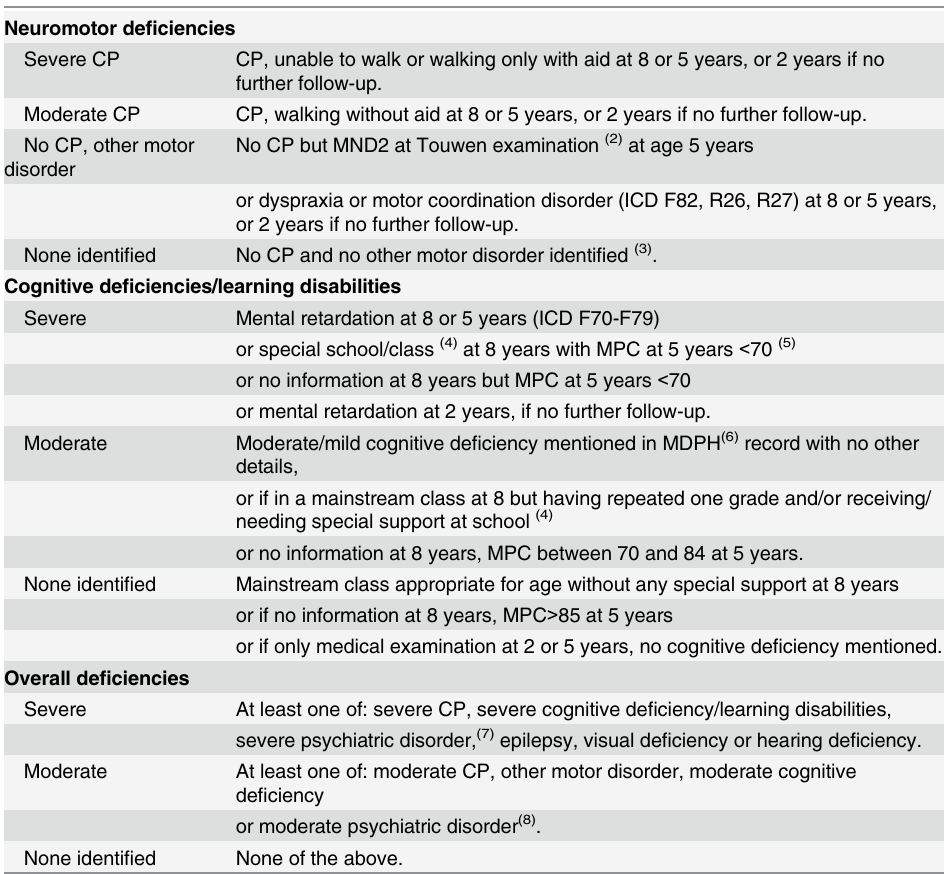
Table 1. Classification of deficiencies. (1) [22] Neuromotor de fi